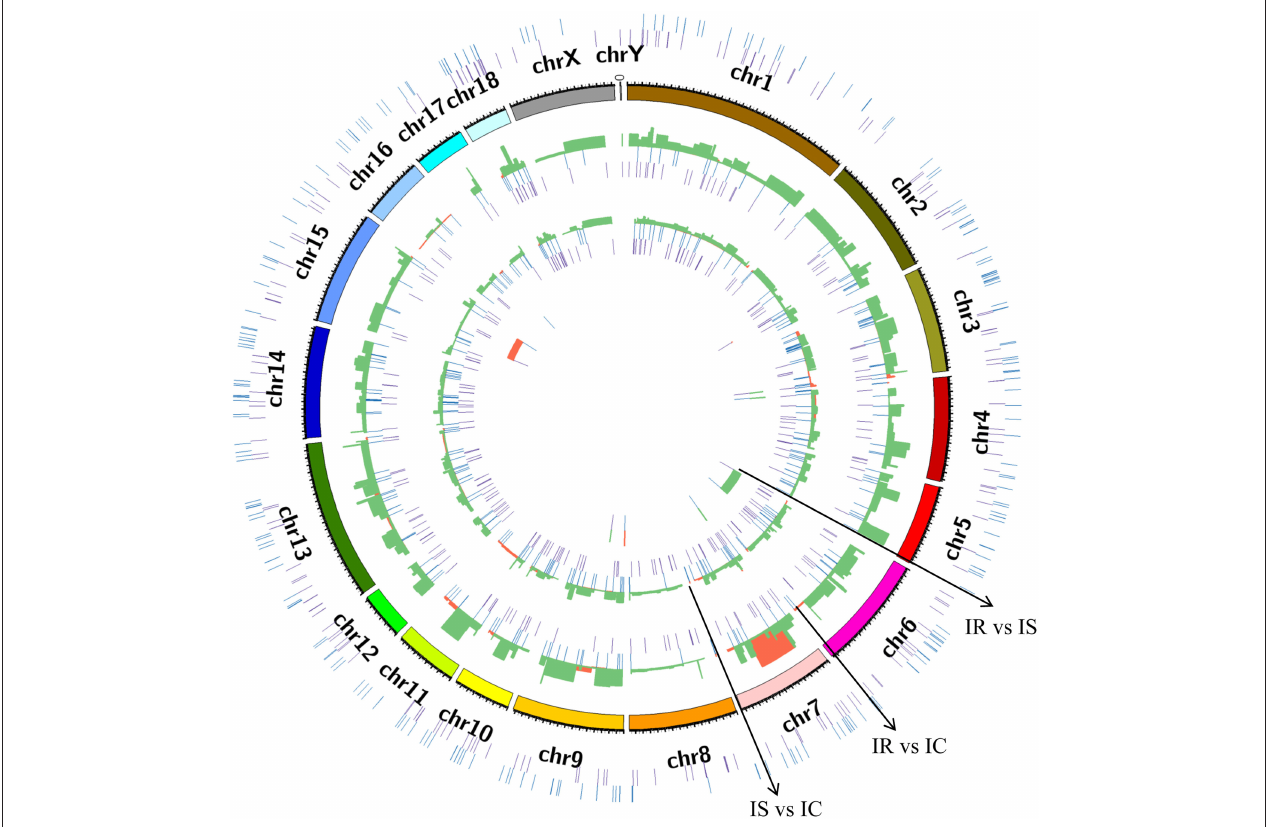
FIGURE 5 | Circular chromosome distribution of lncRNA identified in piglet ileums across the reference genome and different comparison groups. The outermost circle displays the sum of novel and annotated lncRNAs identified in three comparison groups. The second circle displays pig chromosomes scale. The remaining three circles display the novel and annotated lncRNAs in IR vs. IC, IS vs. IC, and IR vs. IS, respectively. Purple: novel lncRNA; Blue: annotated lncRNA; Red: the up-regulated lncRNA; Green: the down-regulated lncRNA, the red and green were plotted by the log2 (fold change) among IR vs. IC, IS vs. IC, and IR vs. IS